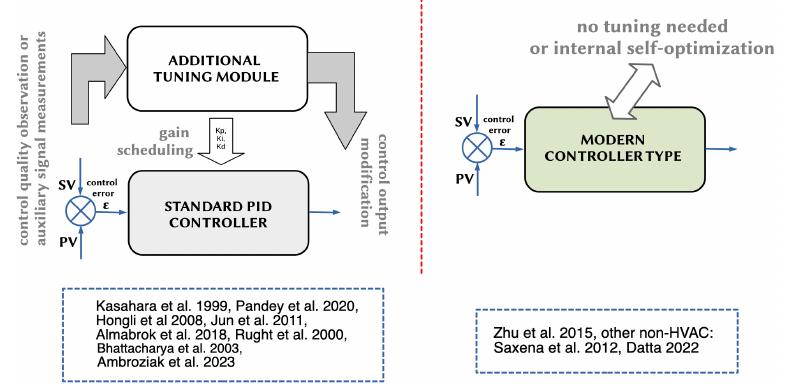
Figure 5. Summary and comparison of selected solutions from the